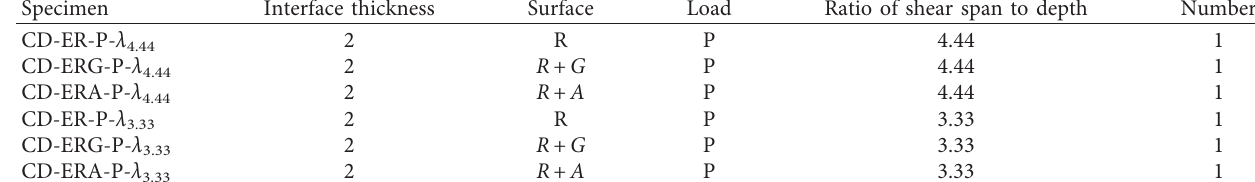
Table 1: Details of specimens.